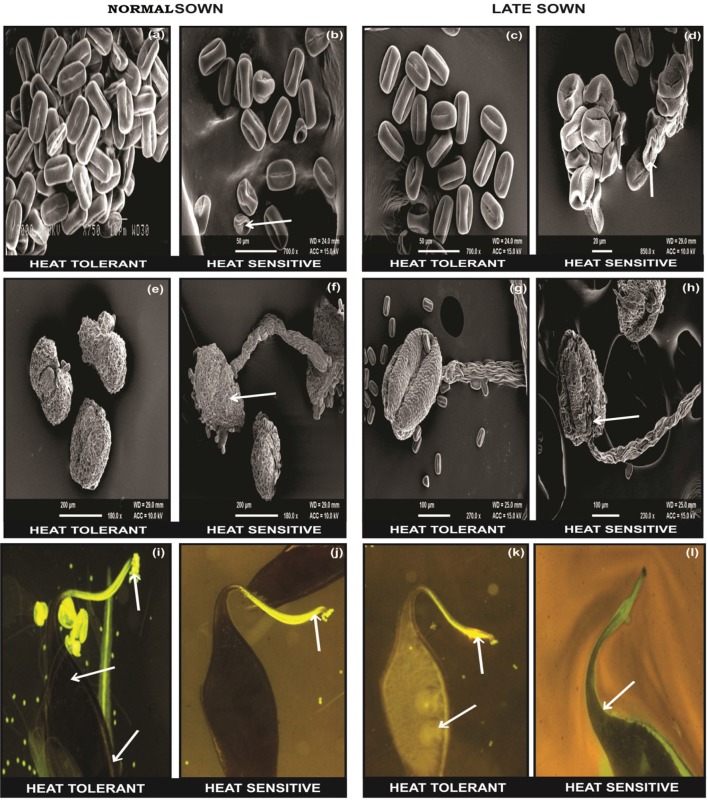
SEM observations under normal (NS) and late-sown (LS) environment on reproductive components in lentil genotypes. Pollen morphology in (a,b) NS and (c,d) LS plants. Anther morphology in (e,f) NS and (g,h) LS plants. Note damage to (d) pollen morphology and (h) anther morphology in LS heat-sensitive genotypes. Fluorescent microscopic studies showing the effects of heat stress on pollen load, pollen tube growth (marked as arrows) in the stylar region and ovular region in (i,j) NS and (k,l) LS plants. Note the (l) lack of pollen tube growth in the stylar region of LS heat sensitive genotypes compared with (k) heat-tolerant genotypes.